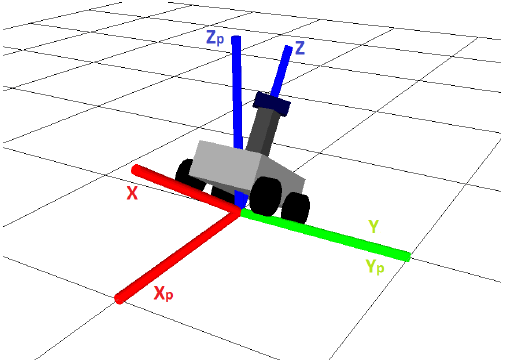
Figure 5. Reference systems for the robot ( XYZ ) and for a leveled 3D scan ( X p Y p Z p